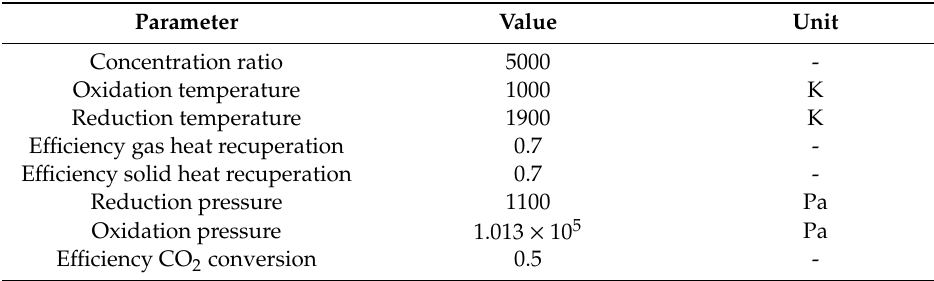
Table A5. Reactor e ffi ciency.